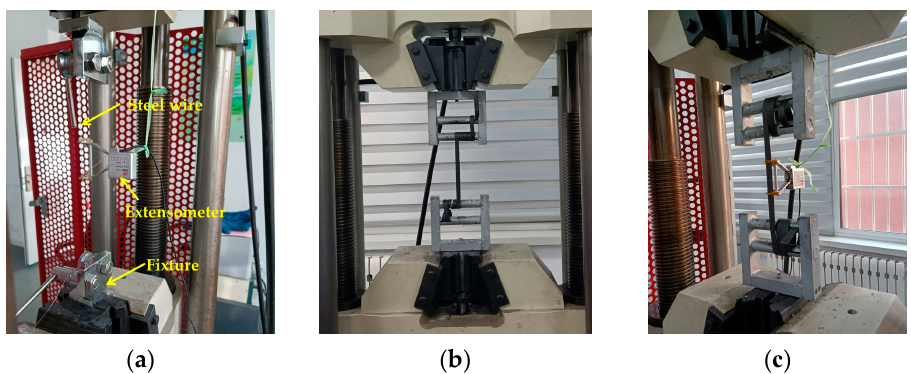
Figure 5. Tensile tests of cold-drawn non-alloy steel wire for springs, polyethylene geogrid belt, and steel–plastic compound geogrids-reinforced belt: ( a ) tensile test of cold-drawn non-alloy steel wire for springs; ( b ) tensile test of polyethylene geogrid belt; and ( c ) tensile test of steel–plastic compound geogrids-reinforced belt.